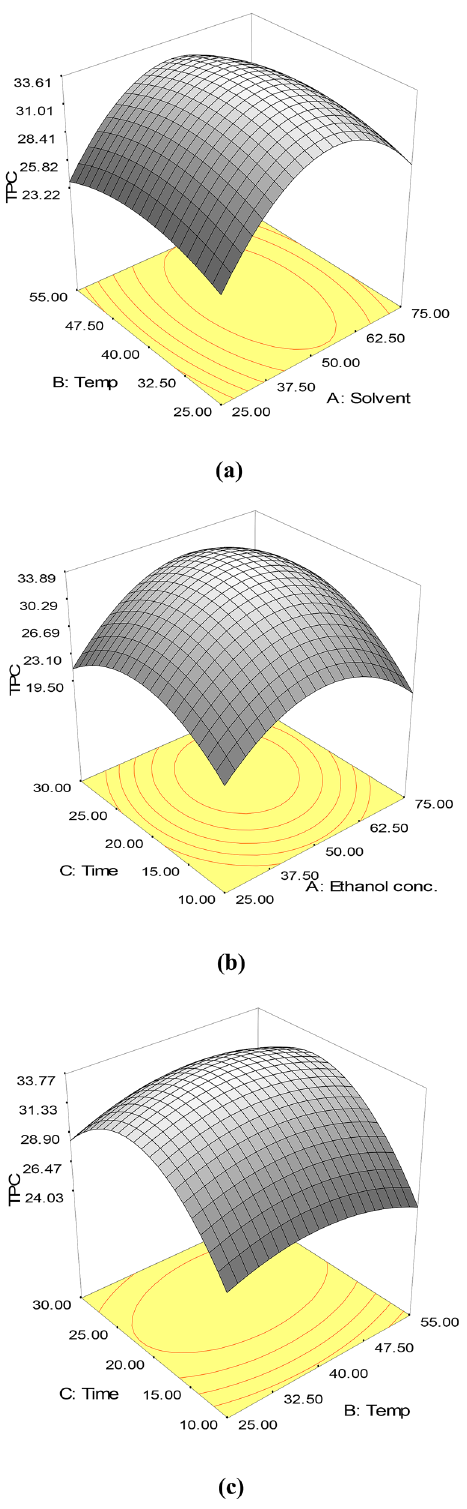
Figure 7. Response surface plots showing effects of ethanol concentration, temperature, and sonication time on total phenolic contents of the extracts from fruits of F. auriculata . ( a ) The constant ultrasonic time (20 min), ( b ) the constant extraction temperature (40 °C), and ( c ) the constant ethanol concentration